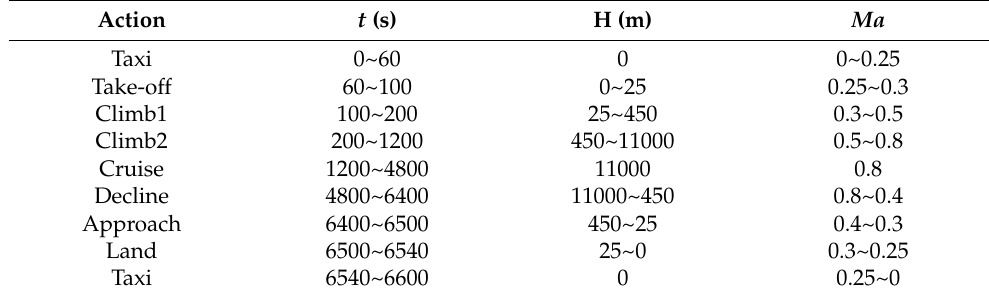
Table 1. A full flight mission profile of the large airliner.